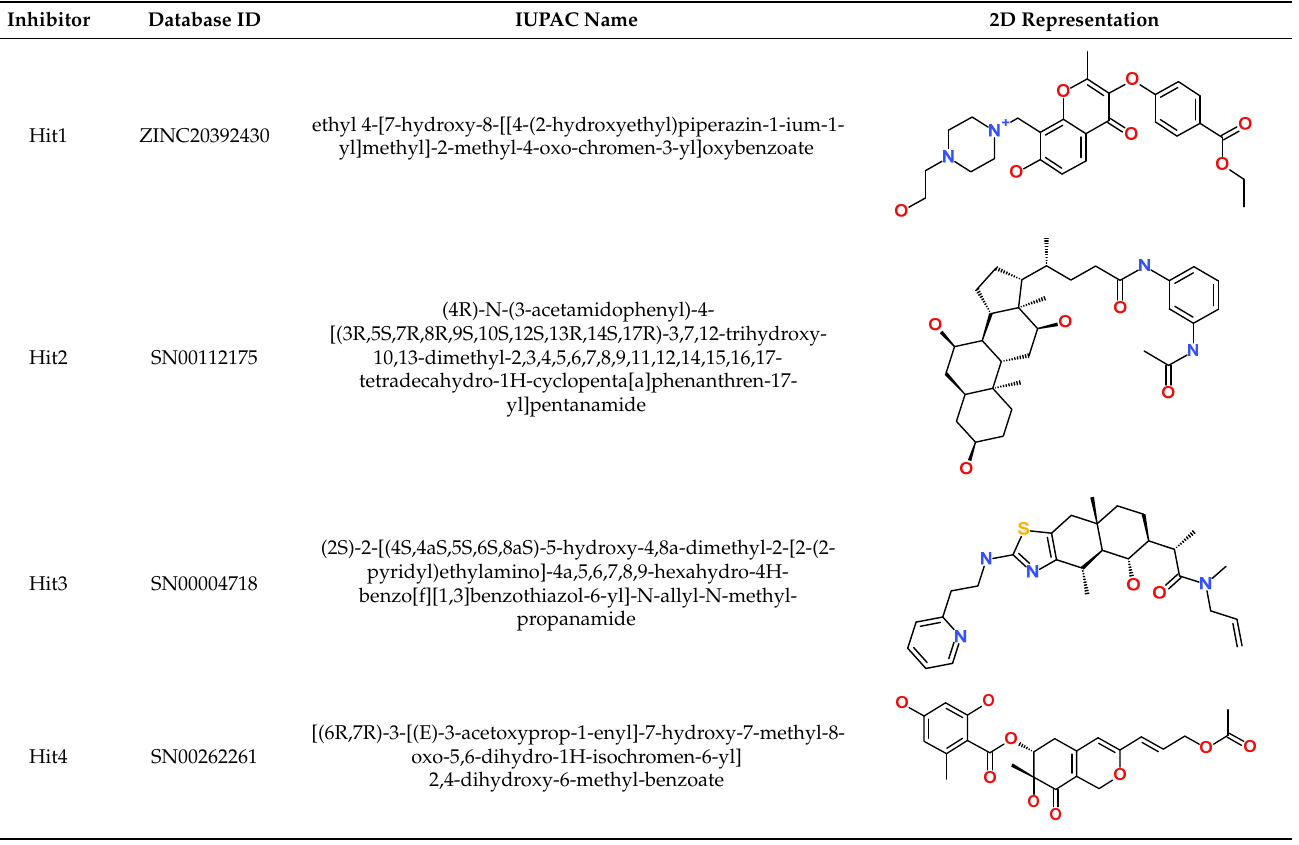
obtained after ROC validation. Figure S2. Molecular docking site used in the present study. The bound ligand THZ1 was used to define the docking sphere. Figure S3. Validation of docking parameters using co-crystallized ligand THZ1 (grey) and docked pose (black). Figure S4. Binding patterns of the reference inhibitors and the hits in the active site of CDK7. Superimposition (left)